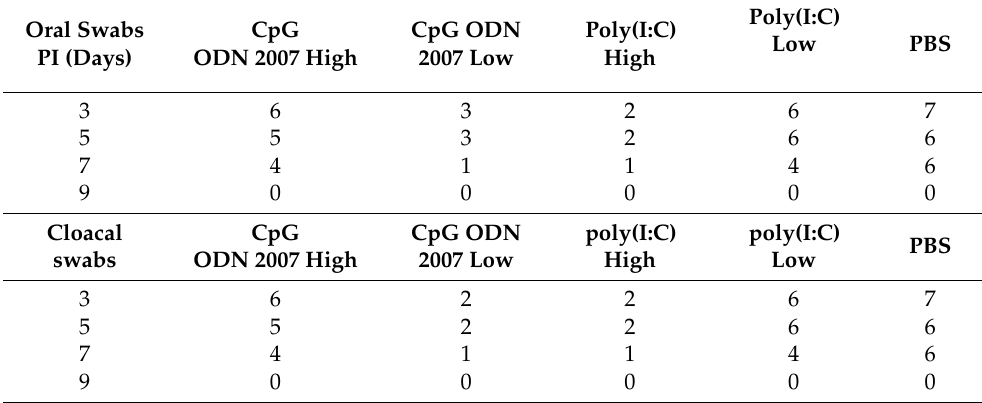
Table 4. Rate of infection in recipient chickens of different treatment